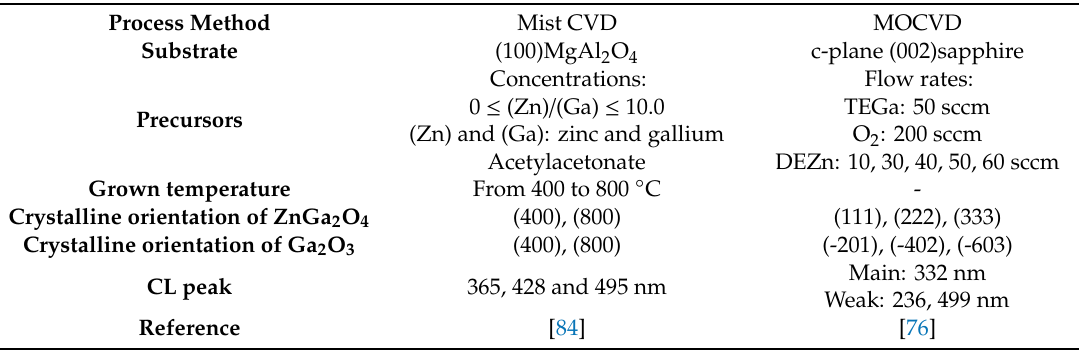
Table 5. Cathodoluminescence (CL) peaks and crystalline orientations with di ff erent process parameters for mist chemical vapor deposition (CVD) and metal-organic CVD (MOCVD).